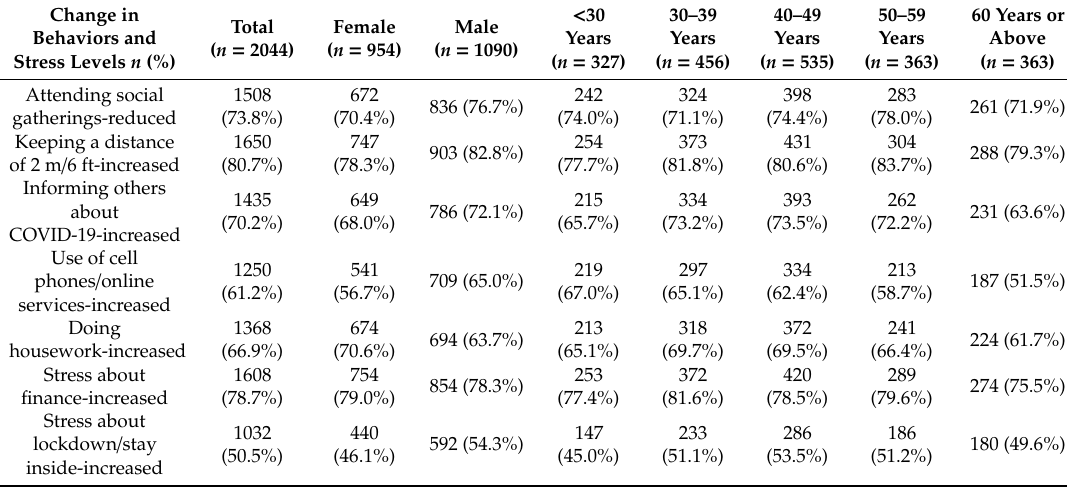
Table 4. Change in behaviors and stress levels after lockdown by gender and age groups across study communities, Tamil Nadu, India, May